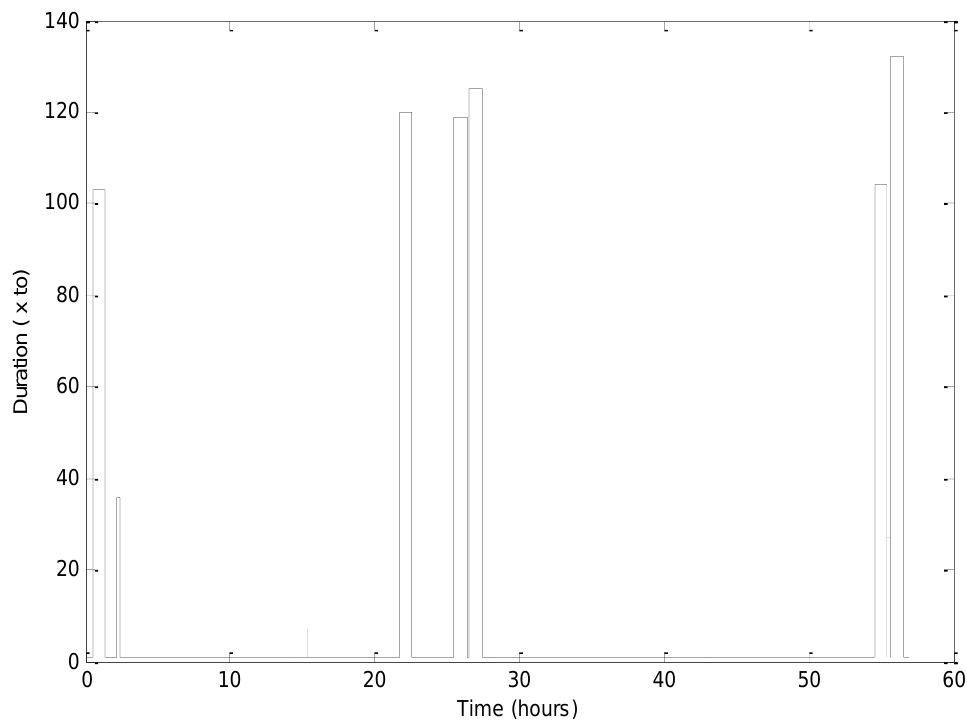
Figure 2. Duration of the interval that separates two consecutives values in an air temperature time series (Data Set A).